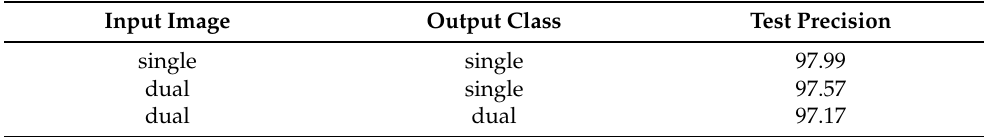
Table 1. Preliminary experiments of digit image classification using MLP trained with MNIST dataset. We verify the accuracy decrease of MLP by task extension. (single input: 28 × 28, dual input 28 × 56, single output: 1 digit, dual output: 2